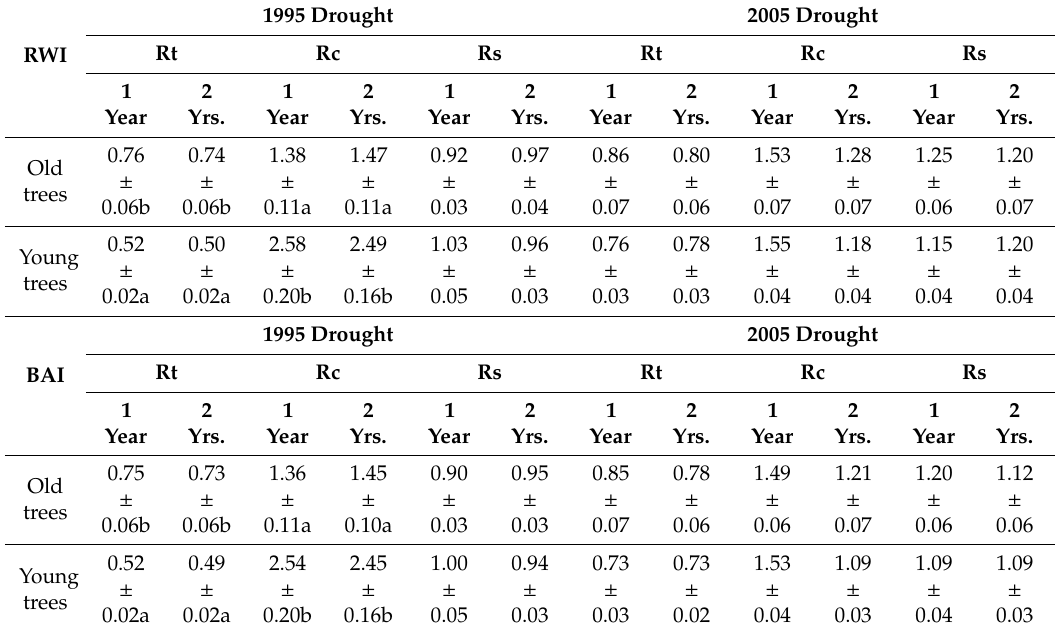
Table 2. Resilience indices (Rt, resistance; Rc, recovery and Rs, resilience) calculated for the 1995 and 2005 severe droughts on individual series of standard ring width indices (RWI) or on a series of basal area increments (BAI) for old and young trees. The indices were obtained for 1- and 2-year periods. Values are means ± SE. Di ff erent letters indicate significant ( p < 0.05) di ff erences between old and young trees according to Mann-Whitney tests.